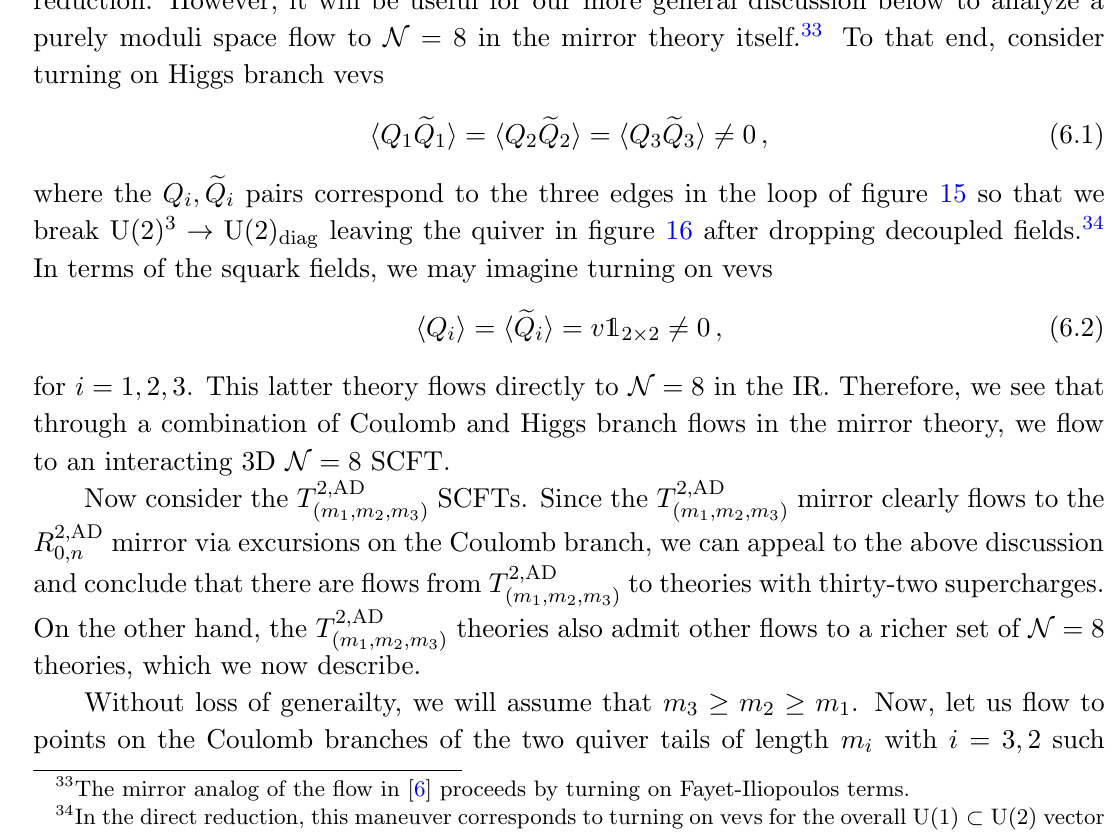
Figure 16 . The mirror quiver obtained after performing the Higgs branch (cid:13)ow from (cid:12)gure 15 described in the main text (we drop decoupled hypermultiplets). The circular line is an adjoint hypermultiplet, and the remaining lines and nodes are de(cid:12)ned as in (cid:12)gure 11. This theory (cid:13)ows to 3D N = 8 in the